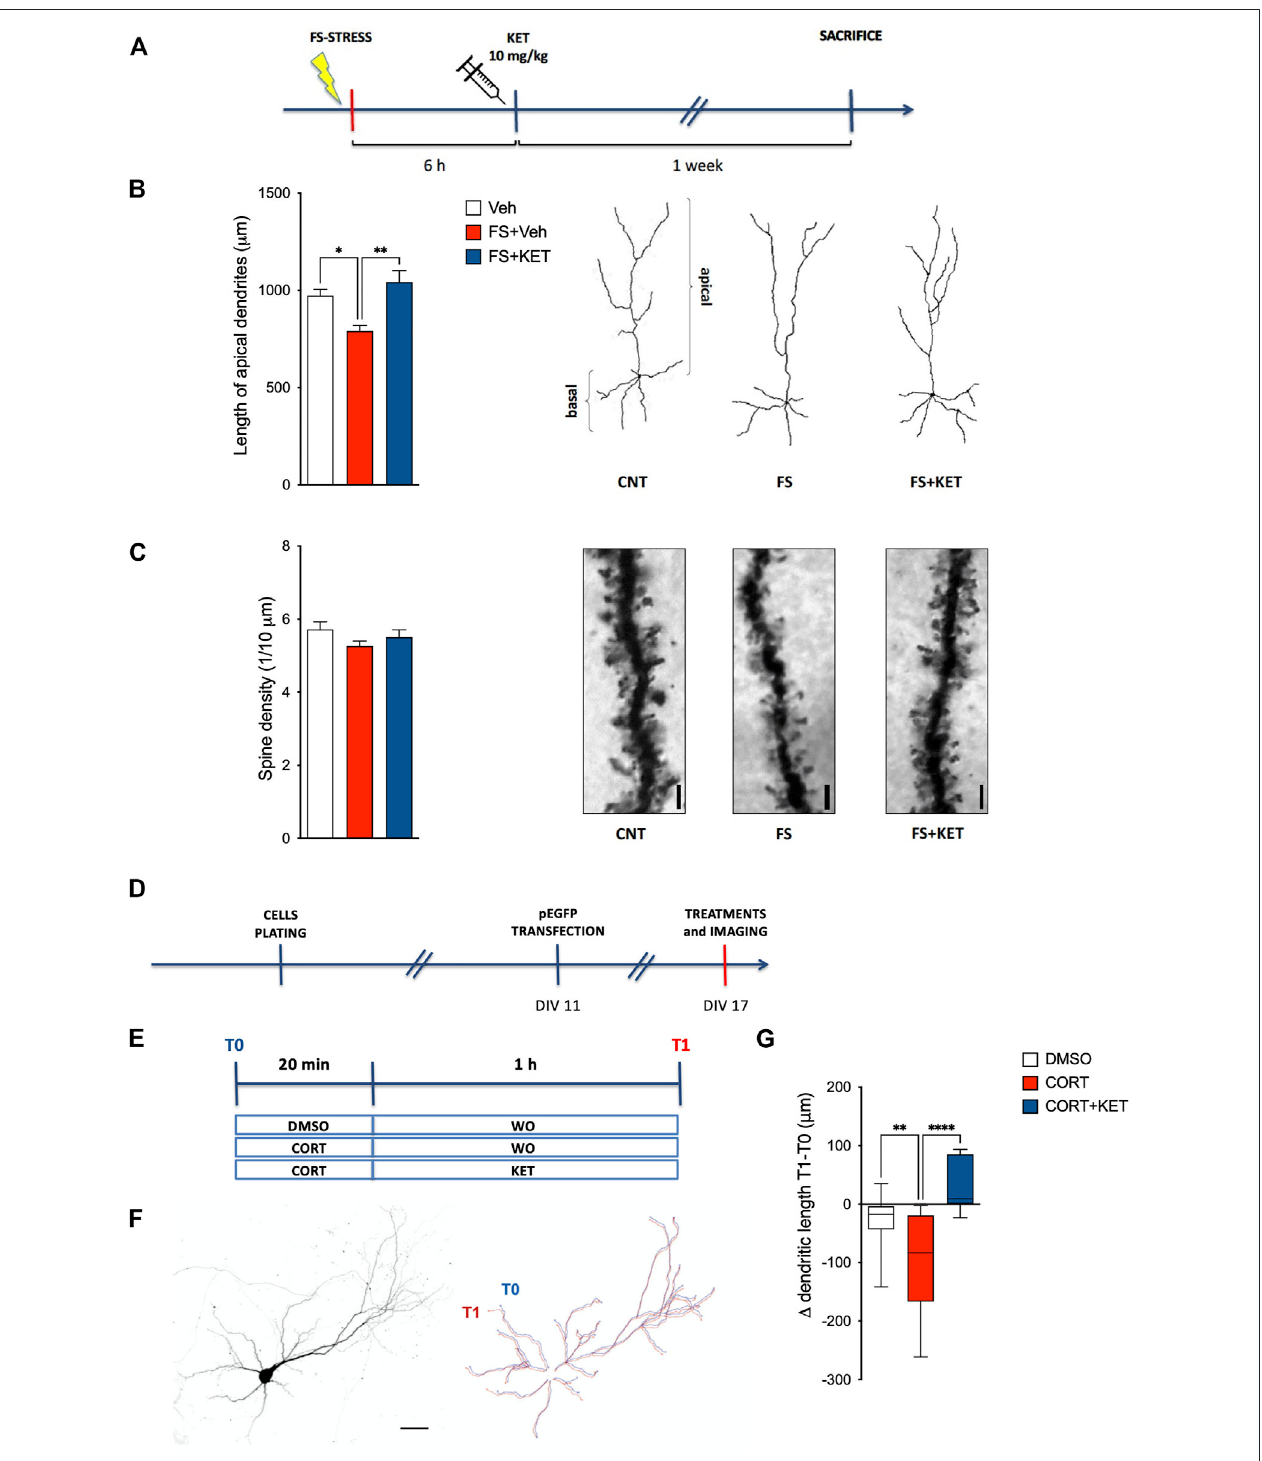
FIGURE 3 | Dendritic arborization. (A) Experimental plan timeline for panels (B,C) . Rats were injected with saline (Veh), subjected to acute FS, and injected with saline6 hafterstress(FS+Veh)orsubjectedtoacuteFSandinjectedwithketamine6 hafterstress(FS+KET).Alltheanimalsweresacri fi ced1 weekafterFS.Changes in the length of apical dendrites (B) and in the number of spines on apical dendrites (C) of pyramidal neurons within PL-PFC layers II – III. Data are expressed as means + SEM. N = 3 – 5 neurons/animal. One-way ANOVA, Bonferroni post-hoc test. * p < 0.05, ** p < 0.01. Insets: representative drawings of PL-PFC layers II – III pyramidal neurons,asreconstructedwiththe “ SimpleNeurite Tracer ” Fijiplugin (B) and representativelightmicroscopeimages ofdendriticsegmentsanalyzed;scale bar=10 μ m